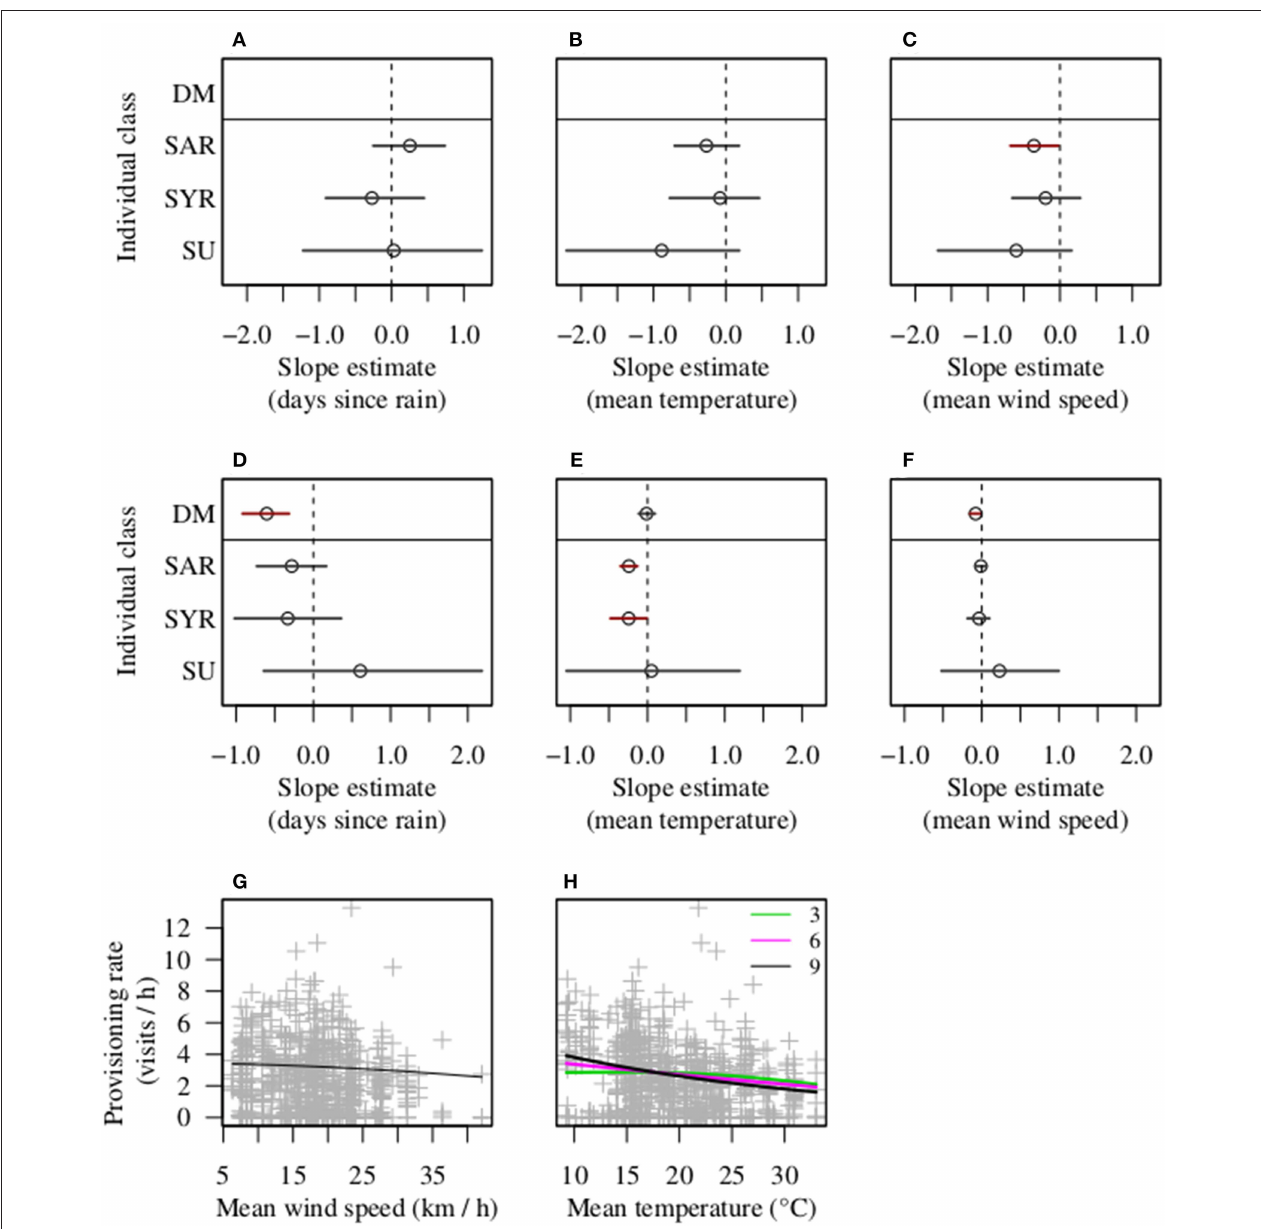
FIGURE 3 | Environmental predictors of carer provisioning rates. Figures show the slope effect sizes for each carer class as a function of the three environmental variables tested, and provisioning rate as a function of meteorological variables and carer number. (A–C) Effects on the probability of not showing excess zero values for days since last meaningful rain, mean daily temperature and mean daily wind speed, respectively. (D–F) Effects on the provisioning rate explained by a Poisson distribution. The slope estimates for non-reference categories were calculated by combining interaction and main effect parameters. Acronyms and meteorological measures are as for Figure 2 . Bars show 95% CI, with black bars overlapping zero and red bars not doing so. (G,H) Effects of wind speed on individual provisioning rate, and an interaction between the number of cares and temperature, respectively. Numbers inset in (H) are the number of carers excluding the breeding female. The curves are predicted expectations of zero-inflated Poisson distribution (i.e., based on both binomial part coefficients and Poisson part